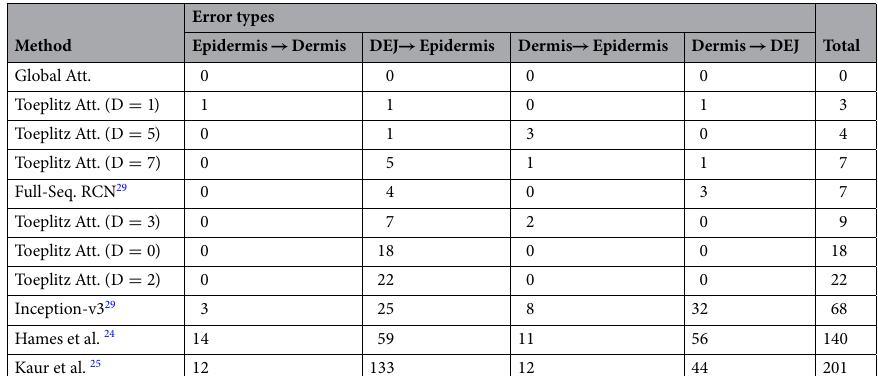
Kaur et al. 25 Table 2. Number of anatomically inconsistent predictions made by each model. Models are sorted in ascending order with respect to the total number of errors.